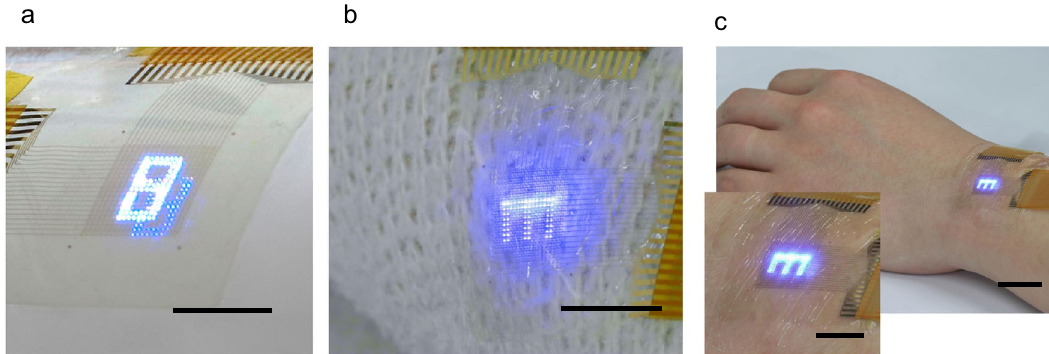
Fig. 4 Micro-LED array for sticker-like ultrathin display on various substrates. a Optical image of micro-LED display on a curve glass with a bending radius of 4 cm. Scale bar: 1 cm. b Image of the ultrathin display on a knit fabric. Scale bar: 1 cm. c Optical images of micro-LED display mounted on human skin. Scale bar: 2 cm. The inset provides a magni fi ed view of the display in operation showing alphabet ‘ E ’ . Scale bar: 1